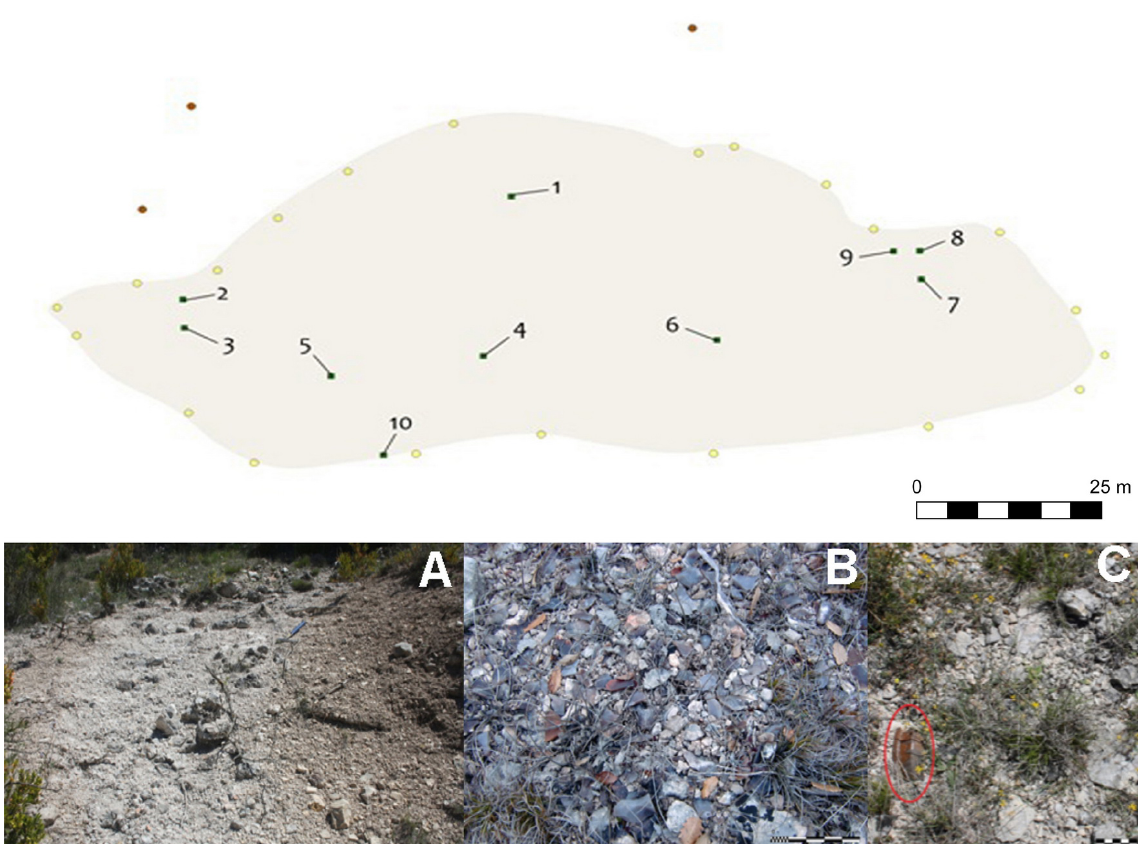
Figure 2. Georeferrenced places with some examples of the three types of places defined during the